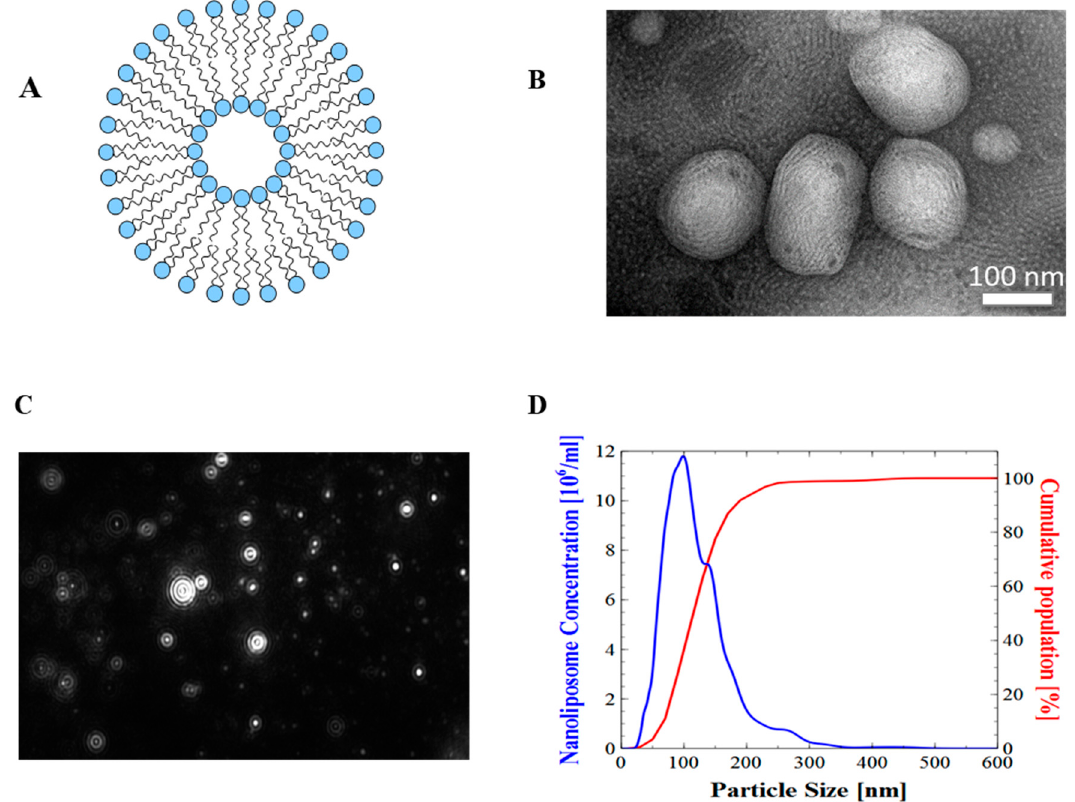
Figure 1. Physical evaluation of nanoliposomes. ( A ) Schematic representation of a nanoliposome; ( B ) transmission electron microscopic images of nanoliposomes; ( C ) nanoliposomes size distribution obtained from NTA (100–400 nm); ( D ) particle hydrodynamic diameter obtained from Nanoparticle Tracking Analysis (NTA) software.